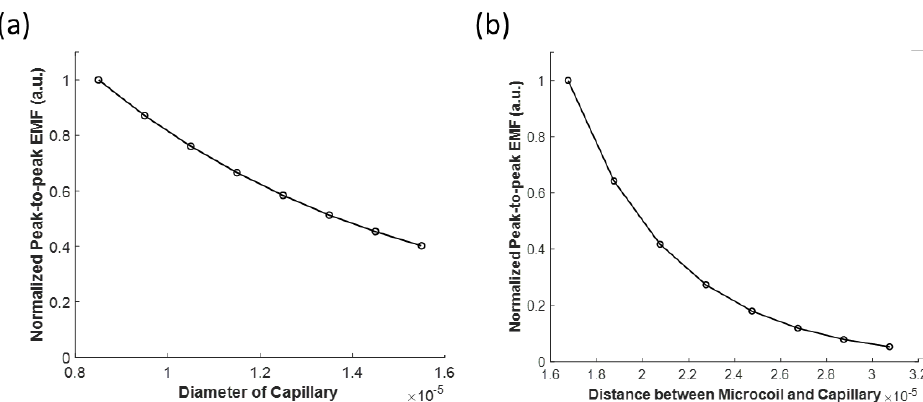
Figure 5. The normalized peak-to-peak induced EMF measured at the microcoil located just above the capillary when changing ( a ) the capillary diameter and ( b ) the distance between the microcoil and the capillary. Table 1. Definitions of variables and values used in the magnetic microcoil for blood cell flowmetery.